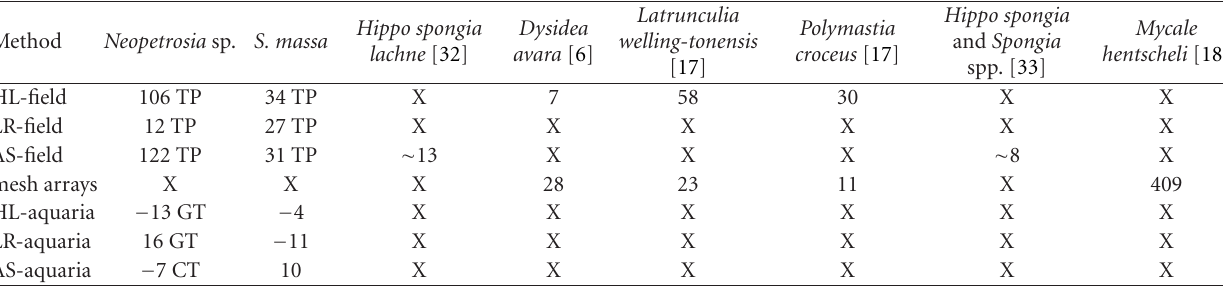
Table 4: Mean percentage growth rates per month